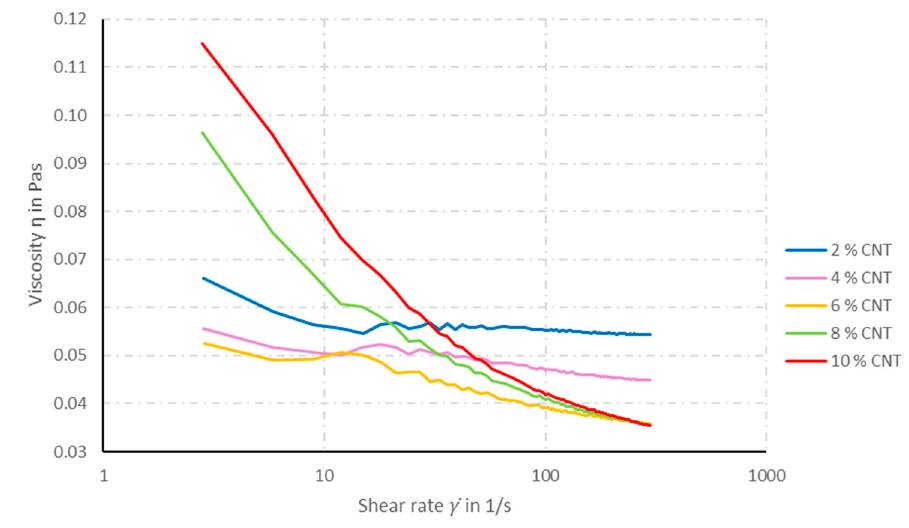
Figure 2. Viscosity of the coating solution as function of the CNT content in the SC; SC is kept constant at 6 wt%.